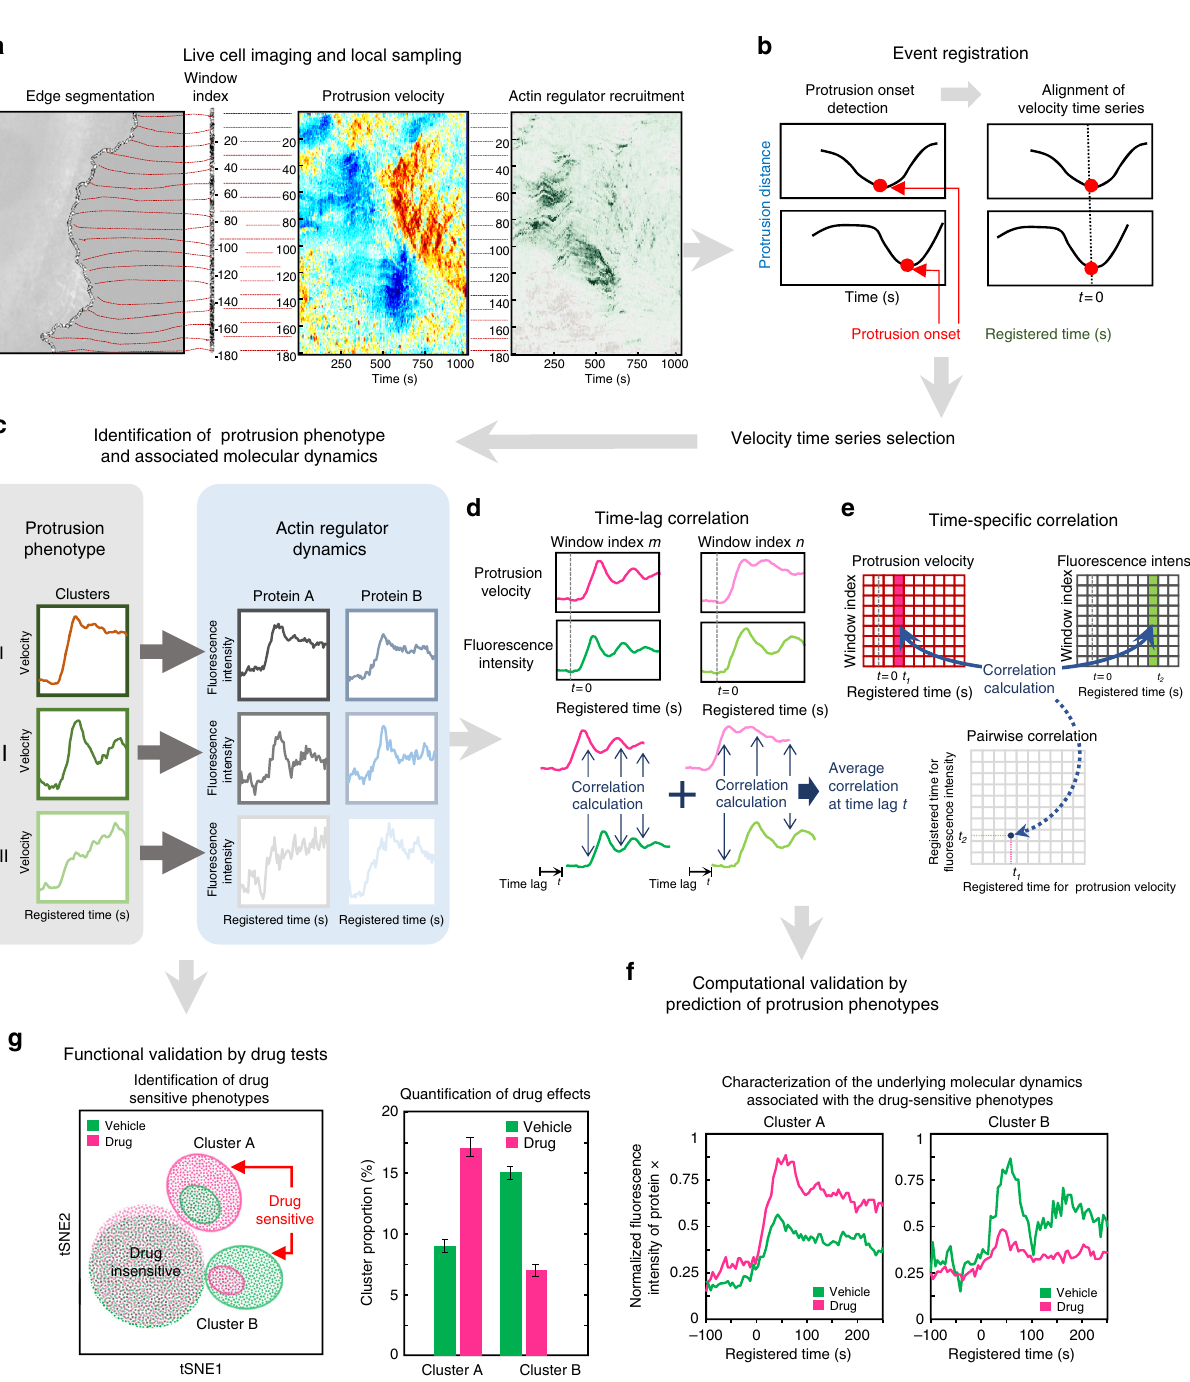
Fig. 1 Schematic representation of the analytical steps of HACKS. a Fluorescence time-lapse movies of the leading edge of a migrating PtK1 cell expressing fl ourescent-tagged proteins of interest (an Arp3-HaloTag expressing cell is presented here) was taken at 5 s per frame, and then probing windows (500 by 500 nm) are generated to track the cell edge movement and sample protrusion velocities and fl uorescence intensities. b The protrusion distance is registered with respect to protrusion onsets ( t = 0). Time series of protrusion velocities are then aligned. c The protrusion phenotypes are identi fi ed by a time series clustering analysis and associated with actin regulator dynamics. d – f Correlation analysis between time series of the protrusion velocities and fl uorescence intensities. Schematic diagrams of time-lag ( d ) and time-speci fi c correlation analysis ( e ) are presented. Classi fi cation analysis is performed to computationally validate the result by predicting protrusion phenotypes based on molecular dynamics. g The hypotheses drawn from the computational analysis are functionally validated by drug tests. The phenotypes susceptible to pharmacological perturbations are identi fi ed based on t-SNE plots. The drug-sensitive phenotypes are further analyzed by quantifying the drug effects on cluster proportion and the associated molecular